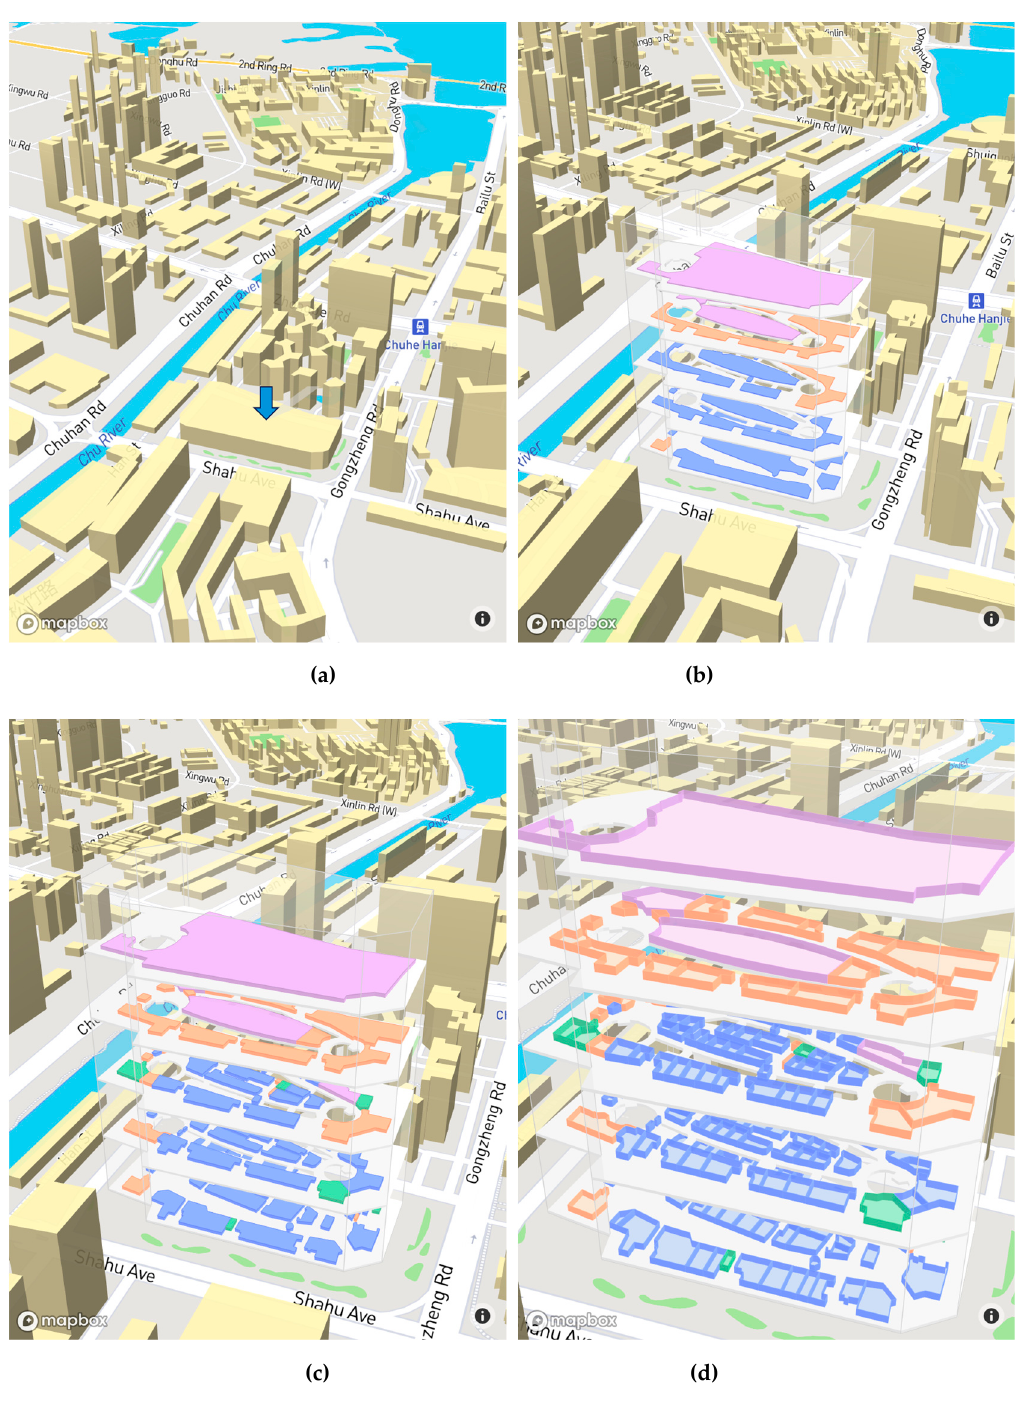
Figure 4. 3D visualizations of the building structure: (a) LOD0; (b) LOD1; (c) LOD2; (d) LOD3.